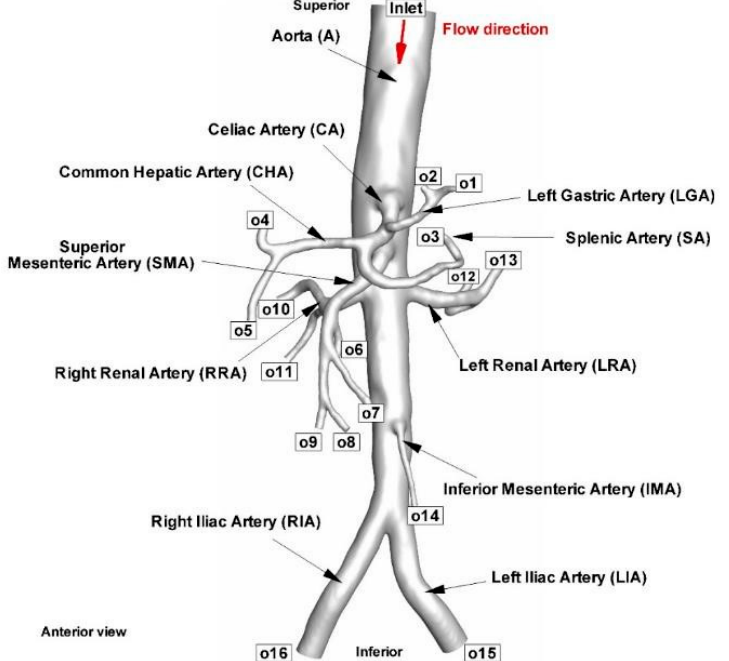
Figure 8. Anatomical representation of the model of the examined blood vessels, including the iliac arteries, major abdominal arteries, and their relationship to the abdominal aorta. Abbreviation for each investigated arterial branch and arterial segment.